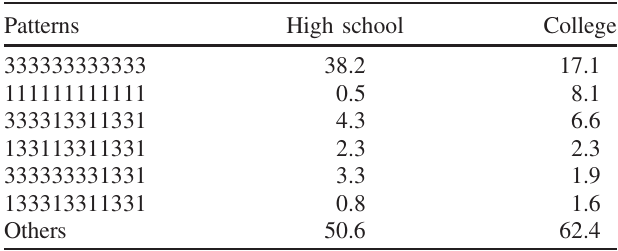
TABLE IV. Percentage ranking of students ’ 12-question re- sponse patterns on the four attributes of causal reasoning in different scenario contexts. The patterns are ordered based on their popularities among college students. Patterns not shown are all with popularities less than 2%.